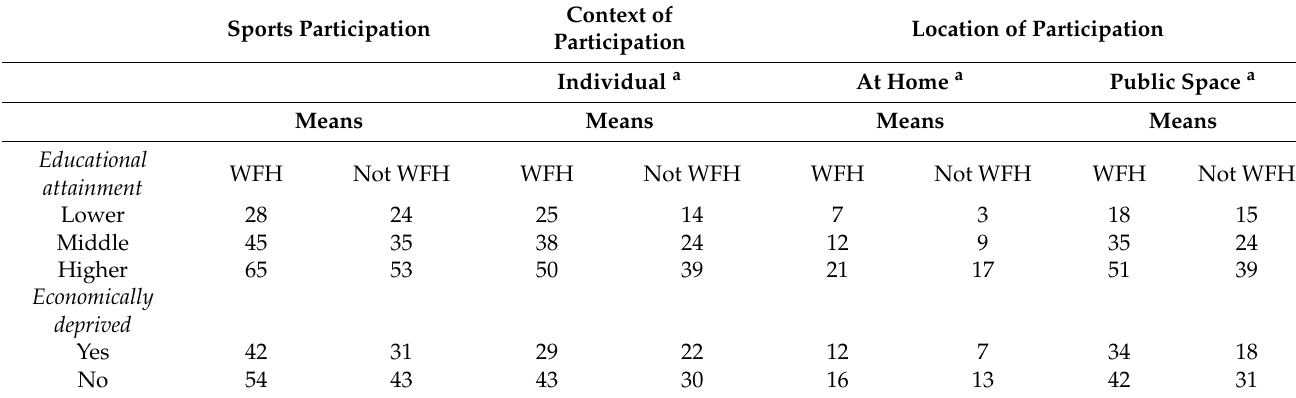
Table 4. Adjusted predicted mean MCA estimates and adjusted ANOVA outcomes of the interac- tion effects.